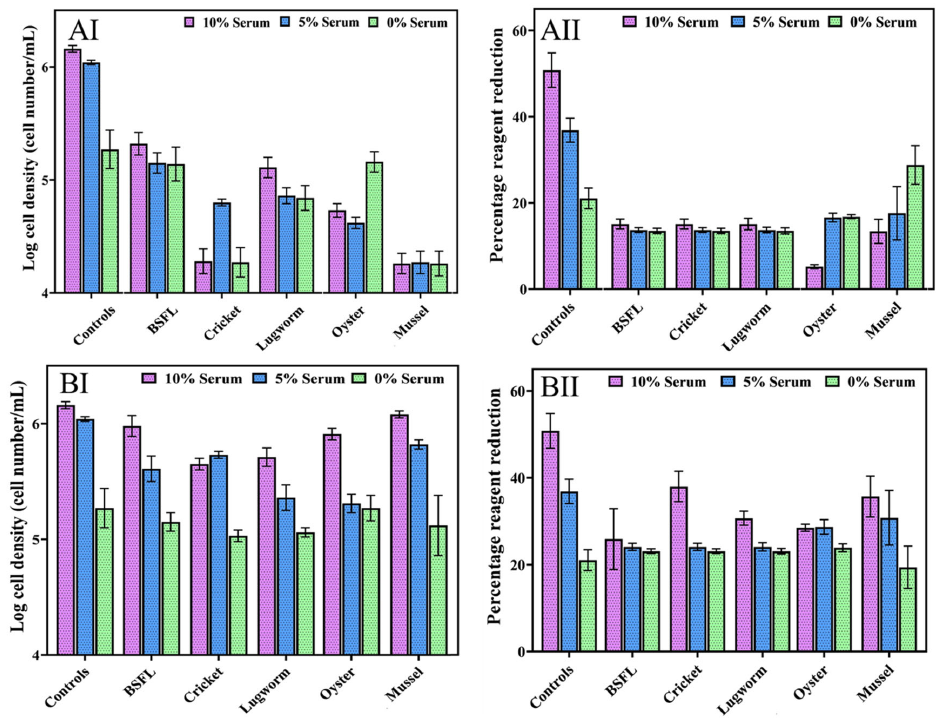
Figure 3. ZEM2S cells’ growth in media containing different serum concentrations (10%, 5% and 0%), ( A ) 10 mg/mL protein hydrolysates (AI: cell growth; AII: cell viability) and ( B ) 1 mg/mL protein hydrolysate (BI: cell growth; BII: cell viability).